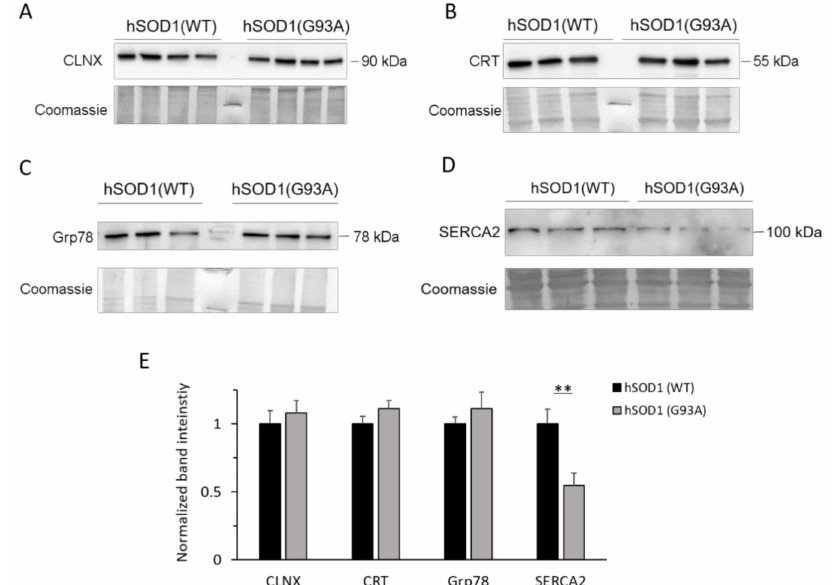
Figure 4. Familial amyotrophic lateral sclerosis (fALS) astrocytes express comparable levels of ER stress-related proteins but lower amounts of SERCA compared to the healthy counterpart. Protein extracts from astrocytes were analyzed by WB for the expression of the Ca 2 + -dependent ER stress markers calnexin (CLNX, A ) and calreticulin (CRT, B ), the unfolded protein response regulator Grp78 ( C ), and the sarco-endoplasmic reticulum Ca 2 + -ATPases (SERCA, D ). In each panel, the upper figures report a representative WB of the protein of interest (run at least in triplicate), and the lower figures show the corresponding Coomassie blue-stained membrane. The bar diagram of ( E ) reports the densitometric analysis of immunoreactive bands for the di ff erent proteins normalized to the optical density of the corresponding Coomassie blue-stained lane. While no di ff erence is observed in the expression of CLNX, CRT, and Grp78, SERCA2 is significantly downregulated in hSOD1(G93A) astrocytes compared to the hSOD1(WT) counterpart. n = 8 (SERCA), 6 (other target proteins) di ff erent primary cultures for each hSOD1 genotype; ** p < 0.01, unpaired two-tailed Student’s t-test. Other experimental details are as